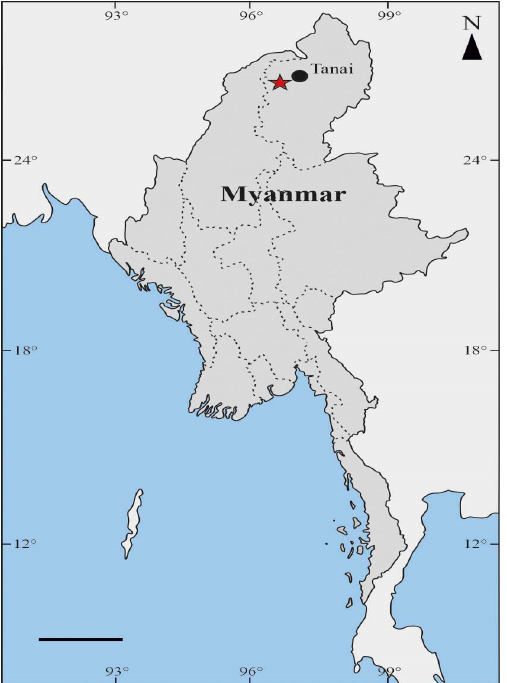
Figure 1. Map of Myanmar. The star marks the location of the Noije Bum hill mines in the Hukawng Valley, Kachin state, 18 km southwest of the town of Tanai (northern Myanmar). Scale bar 200 km.